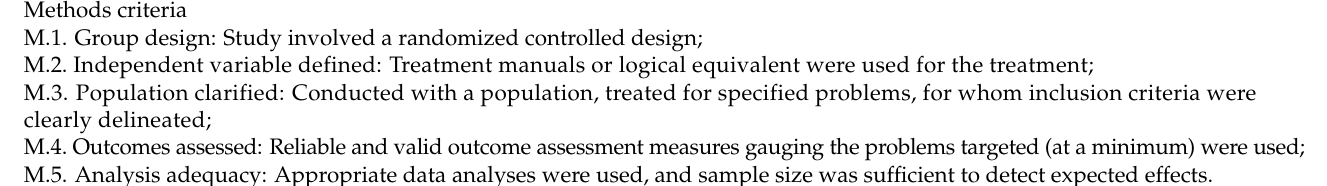
Table 1. Review criteria used for evidence base updates in the Journal of Clinical Child and Adolescent